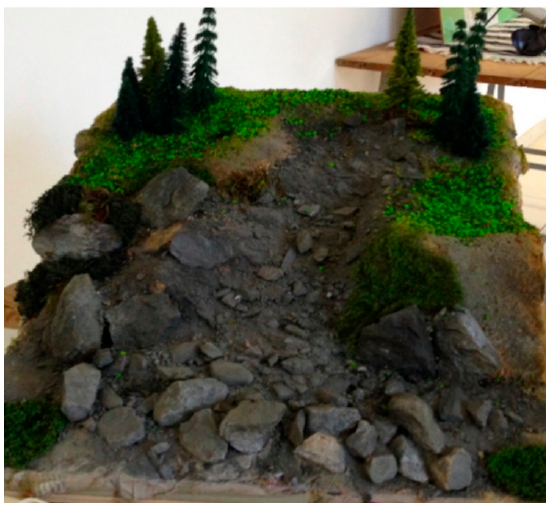
Figure 2. A 3D model of a landslide.